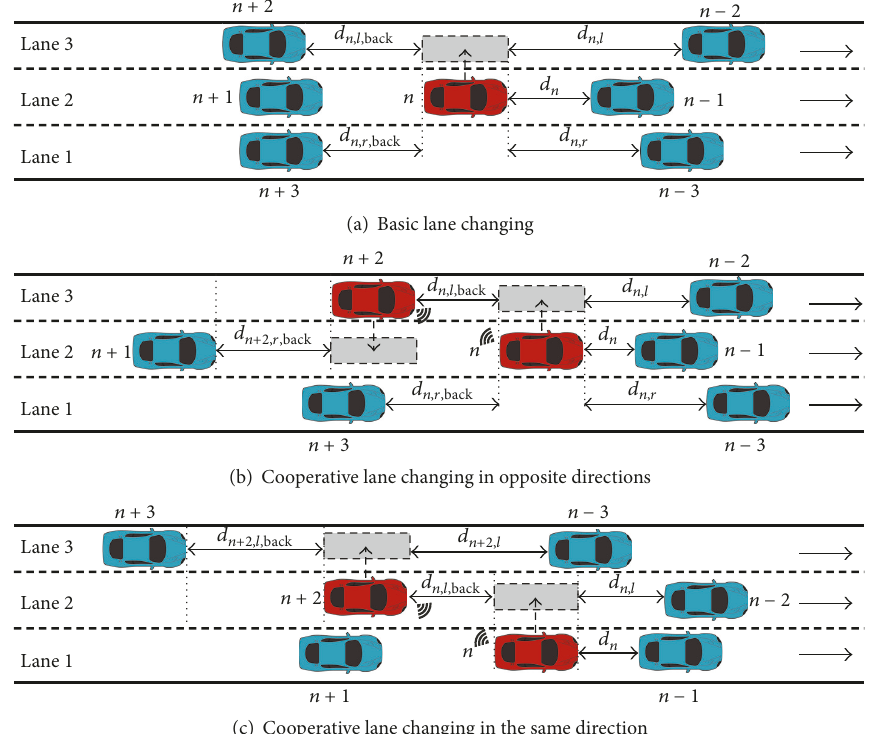
Figure 1: The lane-changing rules and simulation